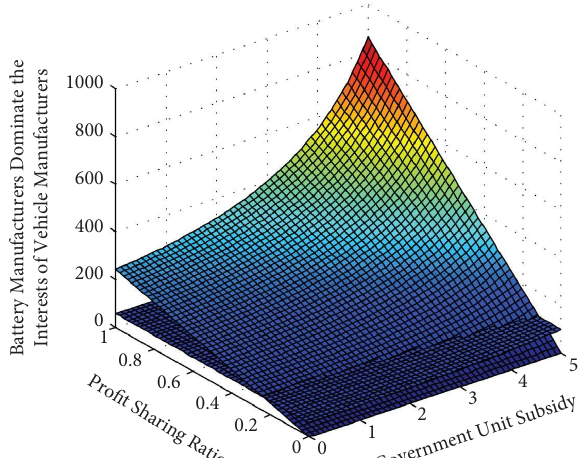
Figure 8: Te infuence of the proft-sharing ratio and government unit subsidy on the interests of battery manufacturers and vehicle manufacturers.